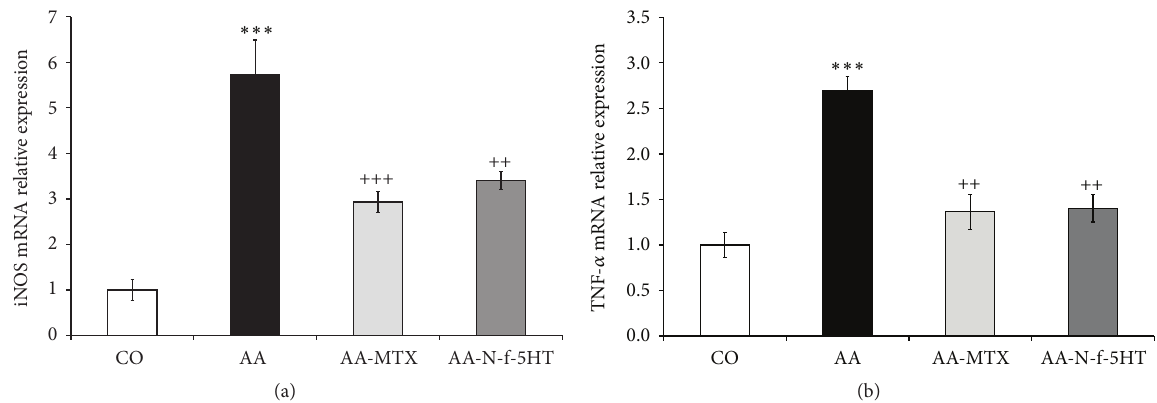
Figure 2: Relative changes of iNOS (a) and TNF- 𝛼 (b) mRNA expressions normalized to 𝛽 -actin mRNA in the rat liver. Control was preset at 1. CO, control group; AA, adjuvant arthritis group; AA-N-f-5HT, adjuvant arthritis group given N-feruloylserotonin; AA-MTX, adjuvant arthritis group given methotrexate. The results are given as average ± SEM; 𝑛 = 8 – 10 . The symbols ∗ and + show significant difference: ∗∗∗ 𝑝 < 0.001 versus CO; ++ 𝑝 < 0.01 versus AA; +++ 𝑝 < 0.001 versus